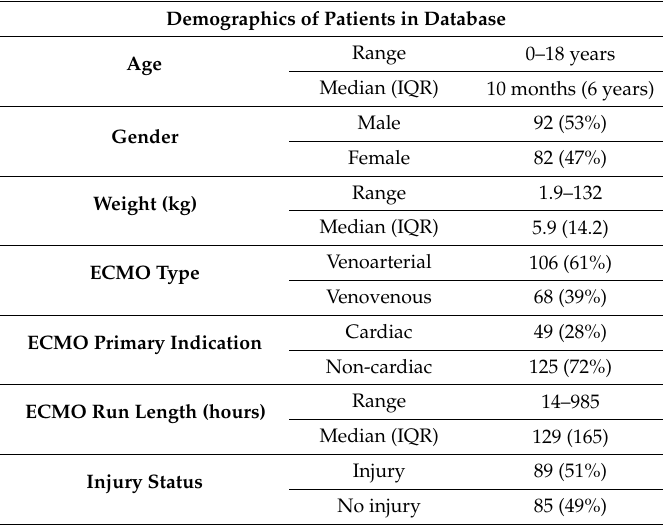
Table 1. Demographic and clinical characteristics of patients included in the study.